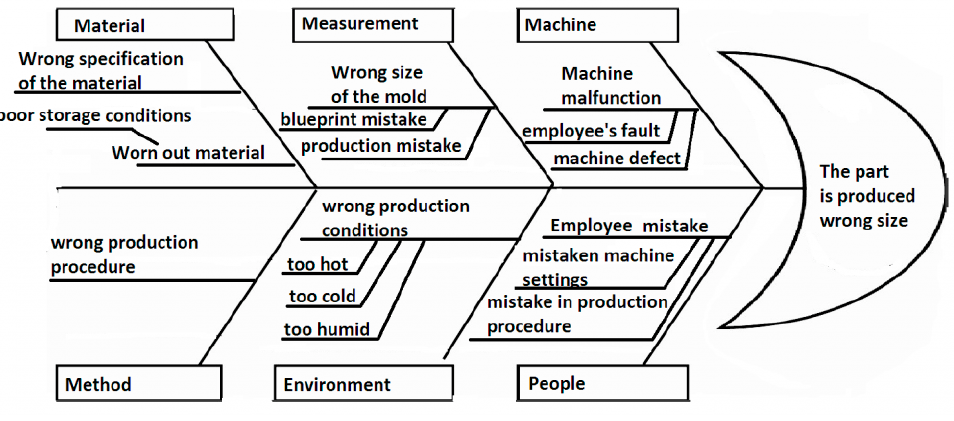
Figure 3. Ishikawa diagram